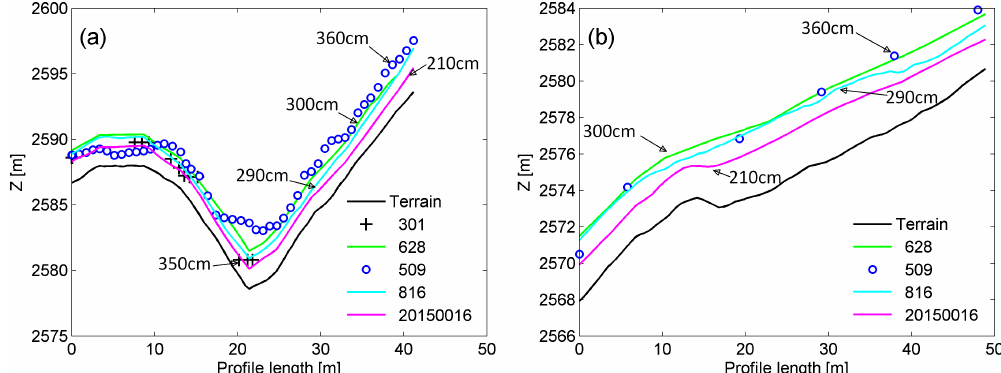
Figure 15. Elevation profiles (a) 2 and (b) 3 (Fig. 13) in snow-covered terrain before avalanche release. The numbers indicate the corre- sponding snow depth measured at the weather